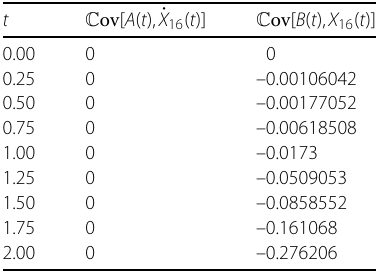
Table 6 Approximation of C ov [ A ( t ), ˙ X ( t )] and C ov [ B ( t ), X ( t )] via accurate truncations ˙ X 16 ( t ) and X 16 ( t ), respectively. Example 4.1, assuming dependent random